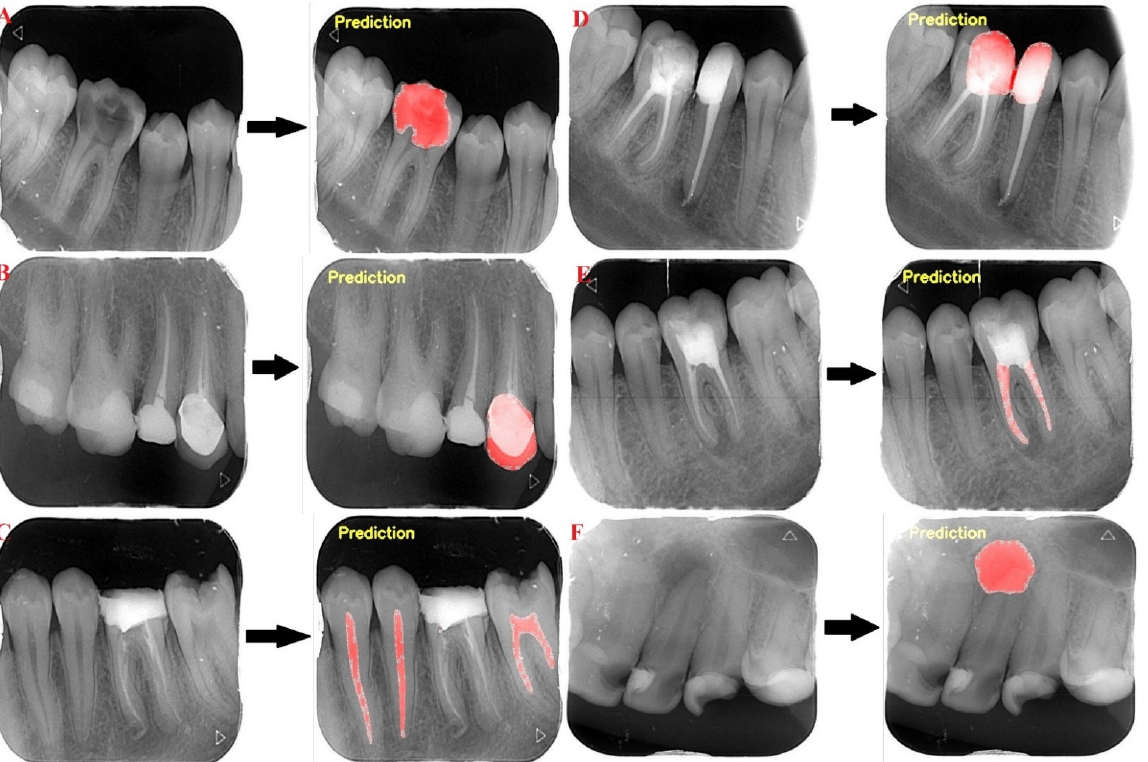
Figure 3. Dental conditions’ segmentation on periapical radiographs using the AI model (( A ) caries,